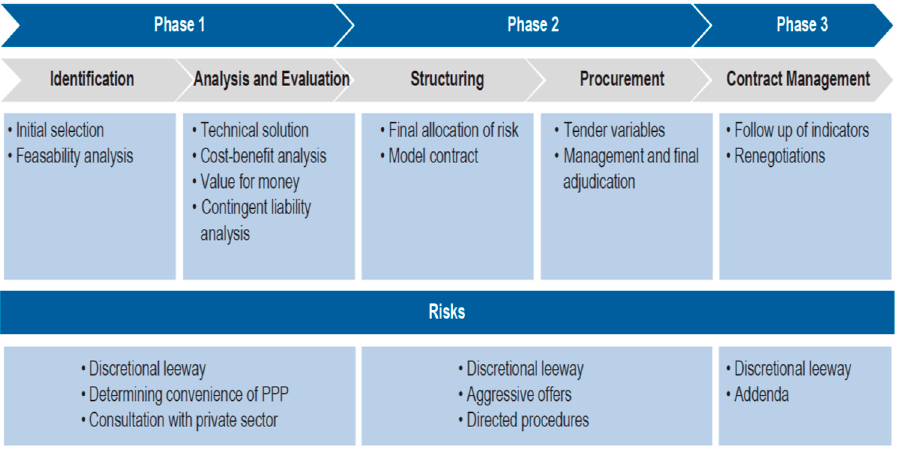
Figure 4. Phases of a PPP projects and risk of corruption. Source: Heydari et al. [7].